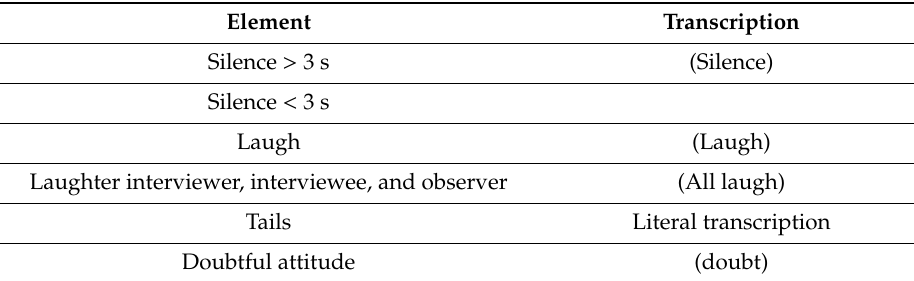
Table 3. Transcription techniques